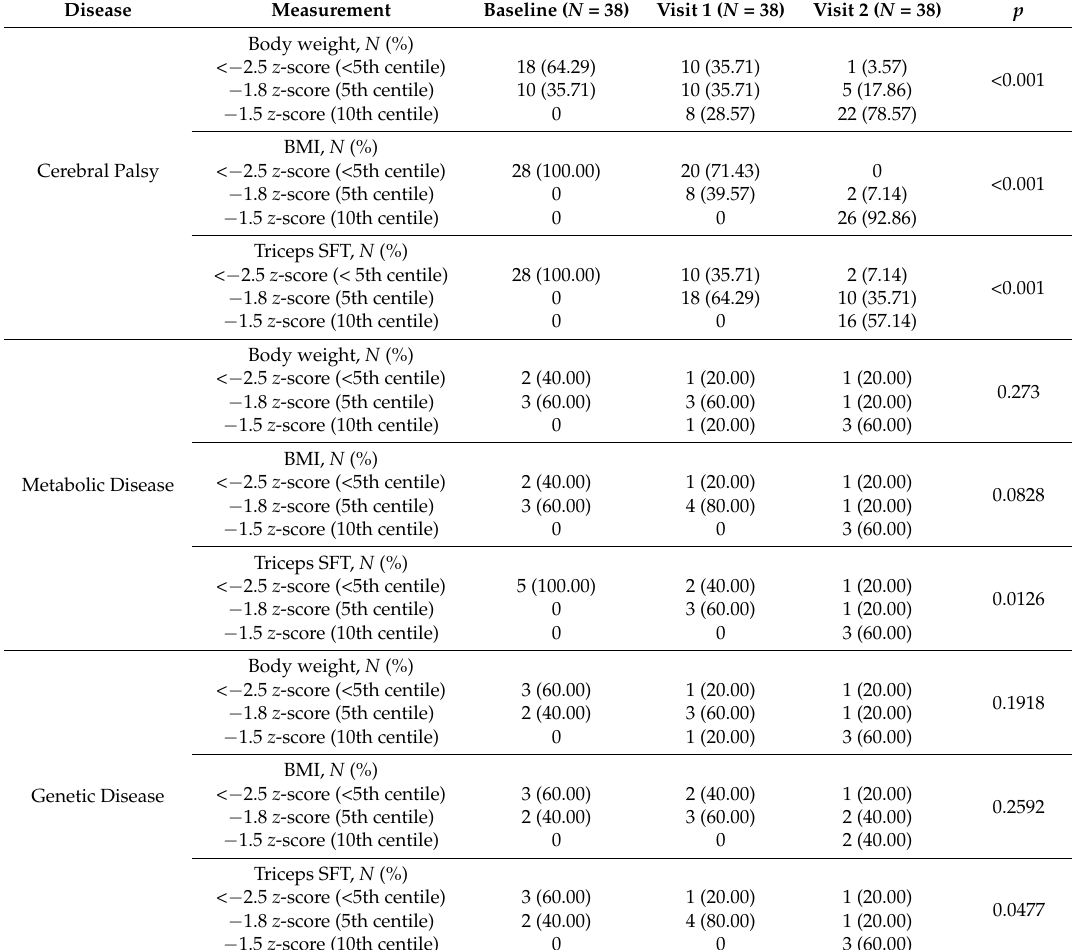
Table 2. Nutritional parameters of children at baseline and at 6 and 12 months after gastrostomy.